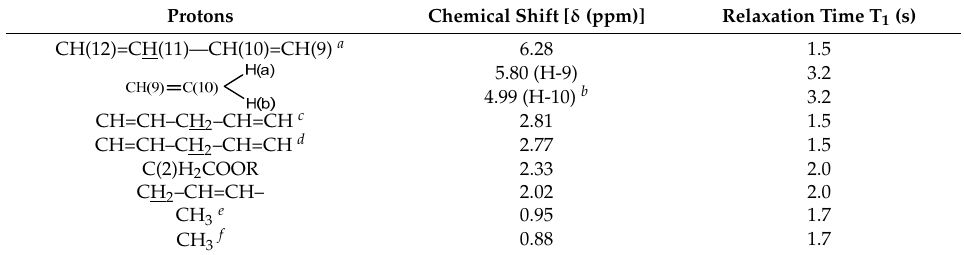
Table 2. Selected NMR signals of the milk lipid fraction and their relaxation times, T 1 , which were used for the quantification of analytes in milk samples.